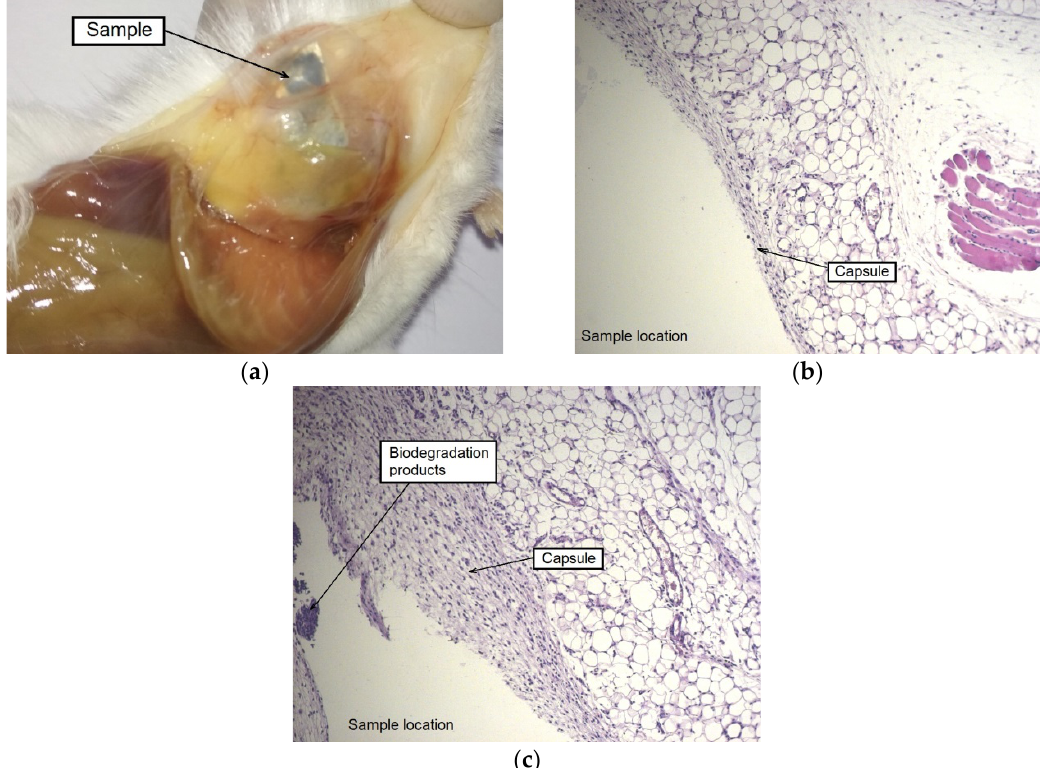
Figure 7. A sample of the alloy WE43 in UFG state and the area around the implantation after two weeks after surgery: the alloy sample with minor signs of degradation, retaining its integrity in the surrounding tissue without signs of gas accumulation and inflammation ( a ), result of a histological examination of tissues of a mouse (HE staining) in the area of contact with a sample demonstrating the formation of a thin-walled capsule around the sample with minor signs of accumulation of biodegradation products and the absence of signs of gas accumulation ( b , c ).